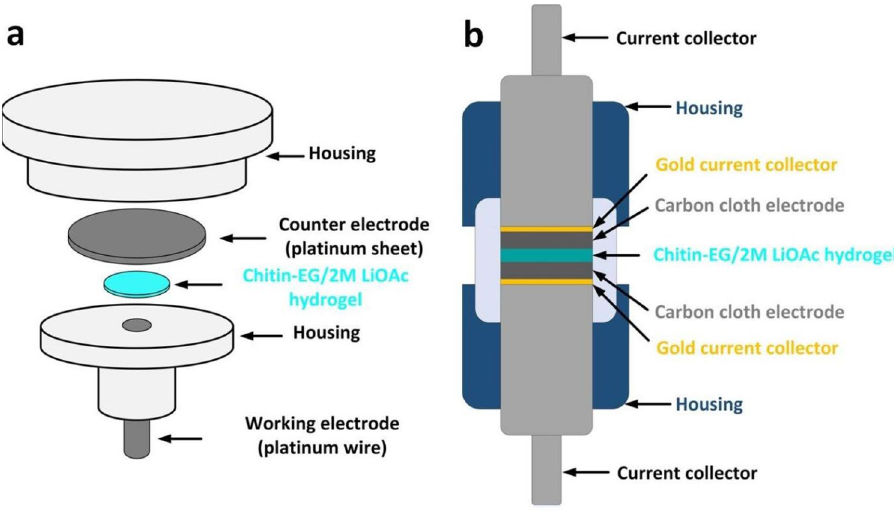
Figure 1. Schematic views of ( a ) the ionic conductivity measuring system; ( b ) cross-section of the electric double-layer capacitor (EDLC) assembled using the Swagelok ®